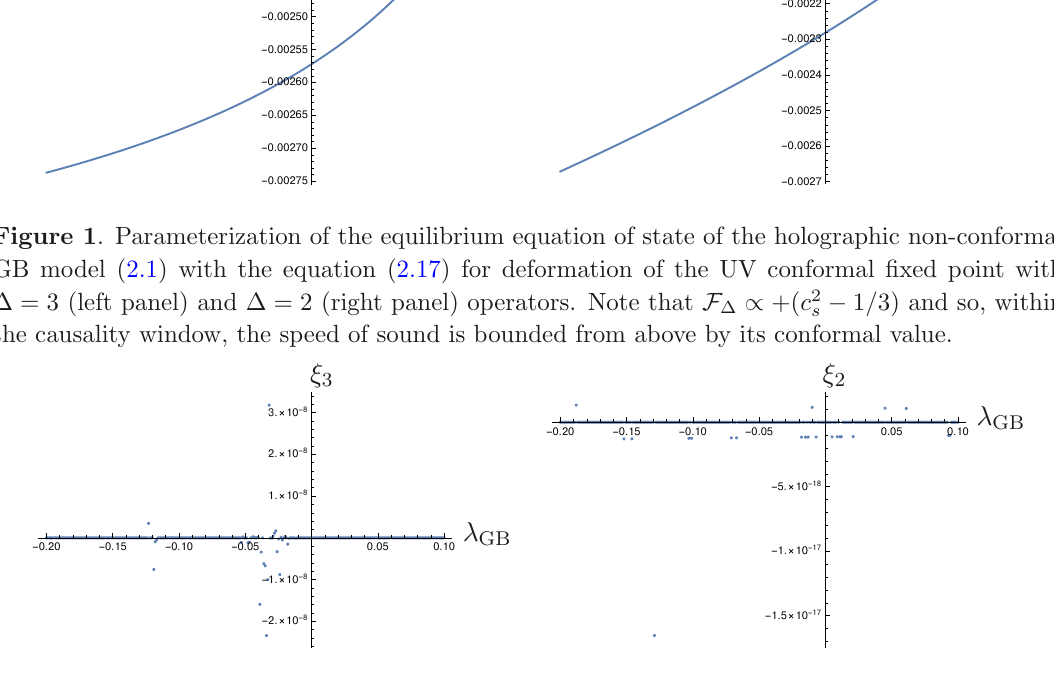
Figure 2 . Numerical tests of the first law of the thermodynamics for the non-conformal GB RG flows induced by ∆ = 3 operator (left panel) and ∆ = 2 operator (right panel). See (2.19) for the parameterization of the deviation ξ ∆